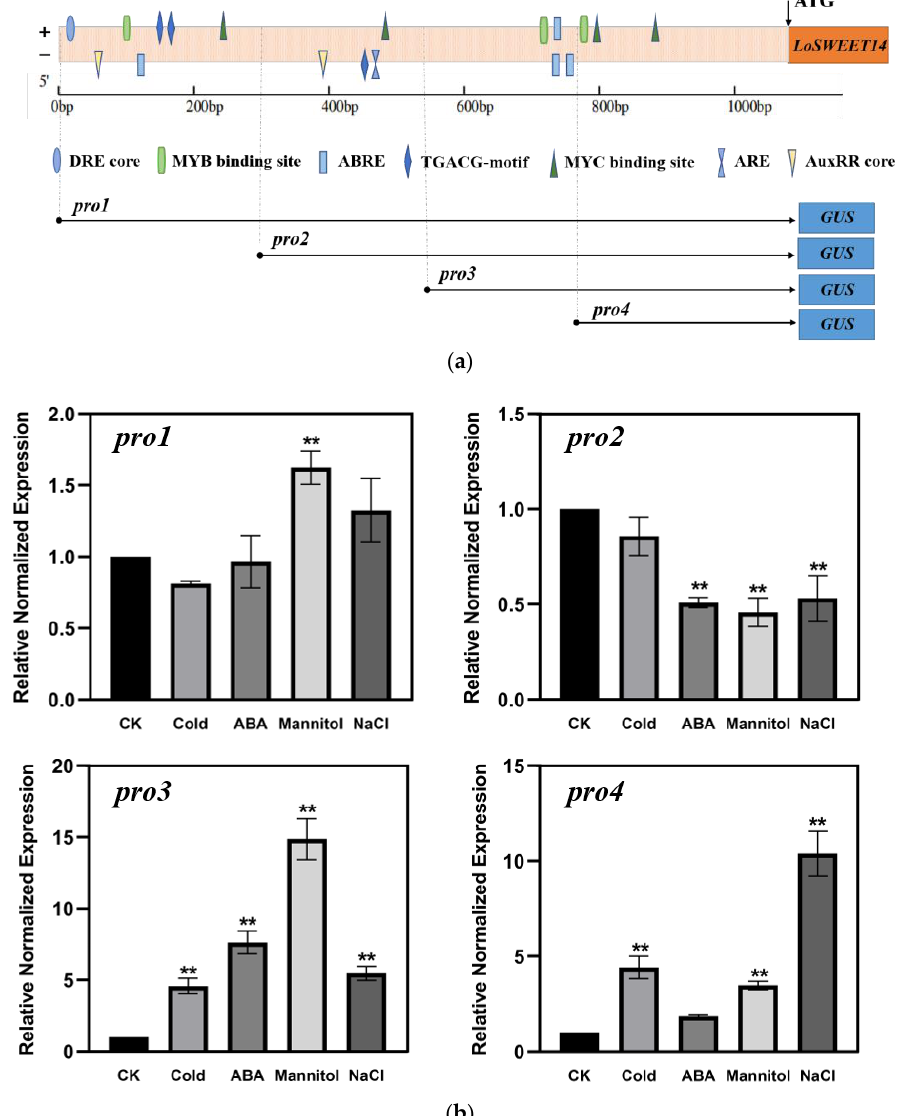
Figure 7. Analysis of the LoSWEET14 promoter in transgenic tobacco under stress. ( a ) Distribution of major stress-related cis-acting elements in the promoter region of LoSWEET14 and schematic diagram of truncated LoSWEET14 -pro fused GUS constructs. The position of the start codon is defined as +1. Different cis-acting elements are represented by different shapes. The numbers on the left represent the length of the 5′ truncated fragments. (b) The expression levels of GUS gene in promoter transgenic Nicotiana tabacum treated with 4 °C, 50 µM ABA, 200 mM NaCl, and 200 mM Mannitol. Each value indicates Mean ± SE (standard error). Asterisks indicate a significant difference ** p < 0.01 compared with the corresponding controls.